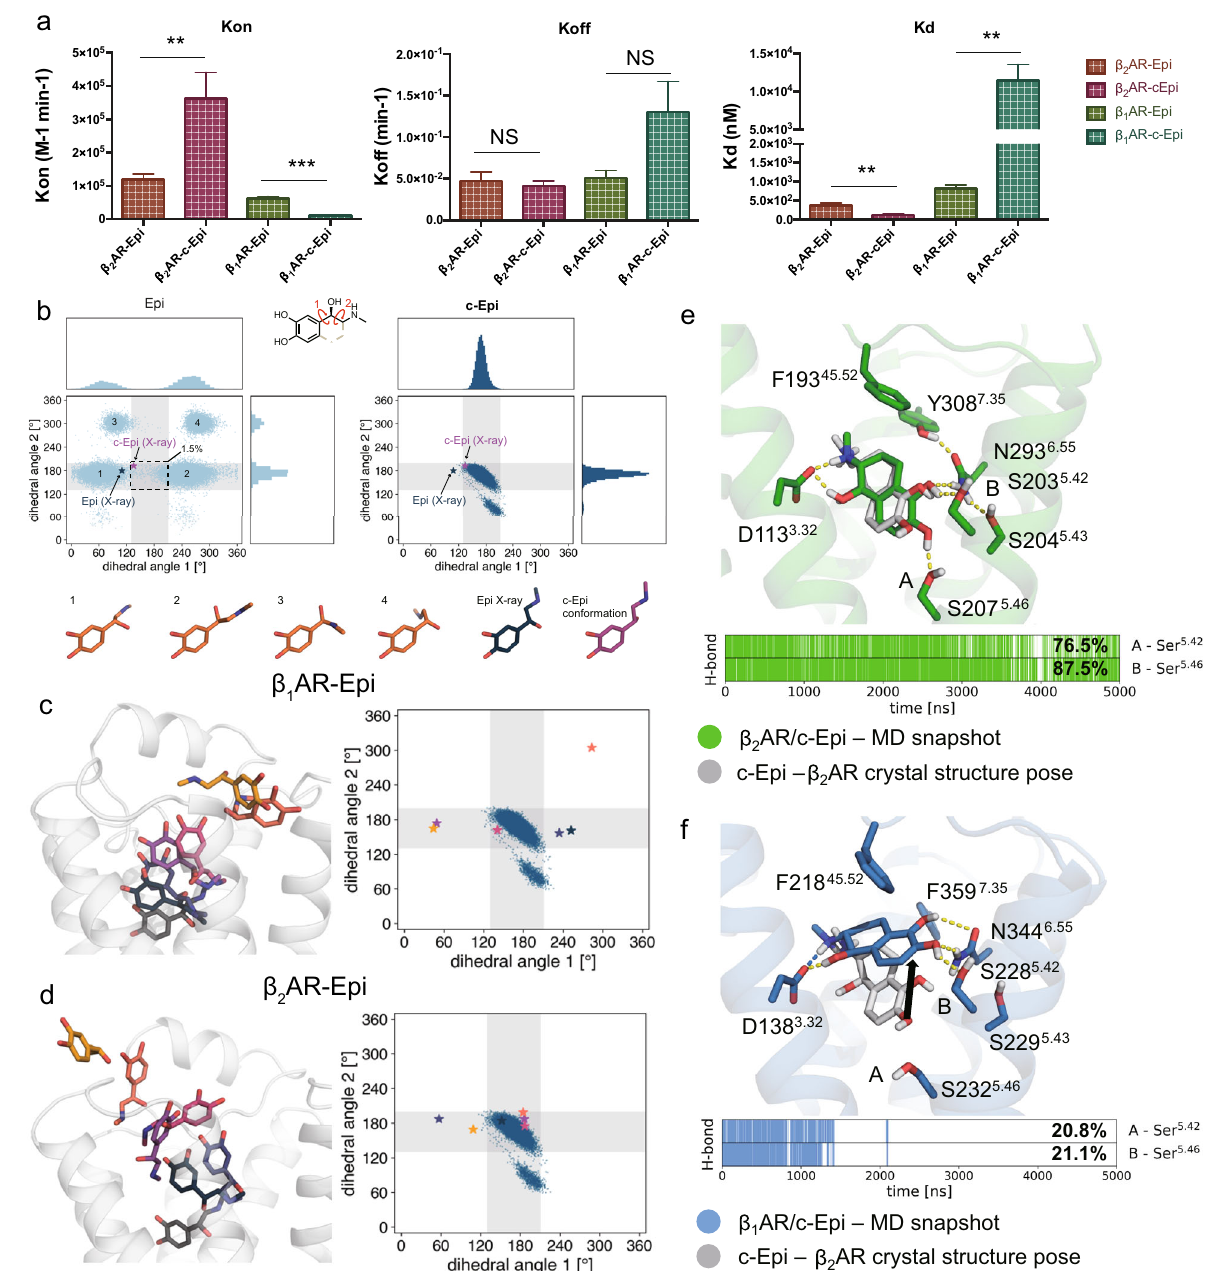
Fig. 3 | The selectivity of c-Epi toward the β 2 AR re fl ects differences in the binding pathways and less stable orthosteric binding pocket interactions in the β 1 AR. a Binding kinetics studies of Epi and c-Epi towards the β 1 AR and β 2 AR. Statistic analysis were performed using two-way ANOVA analysis. (* P <0.05,